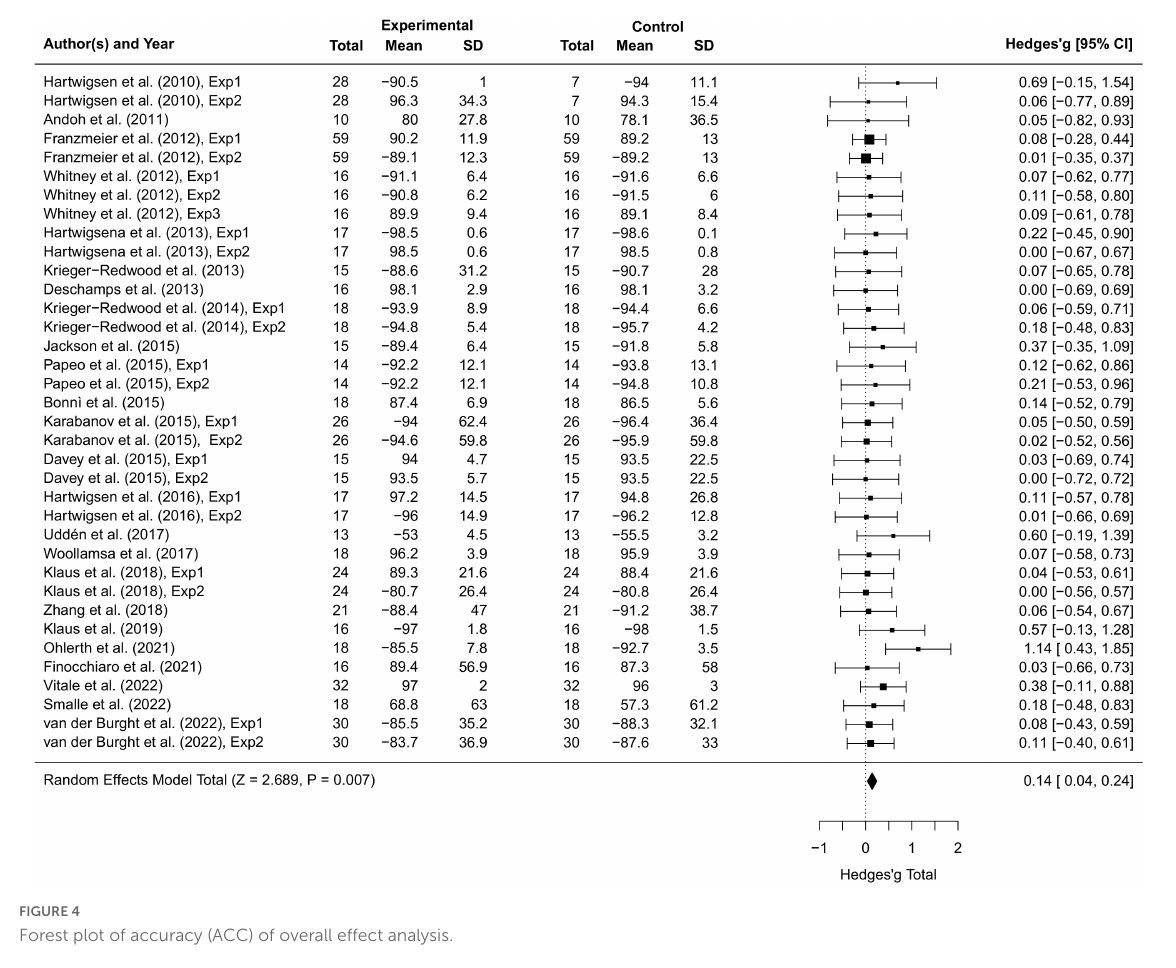
FIGURE4 Forest plot of accuracy (ACC) of overall effect analysis.